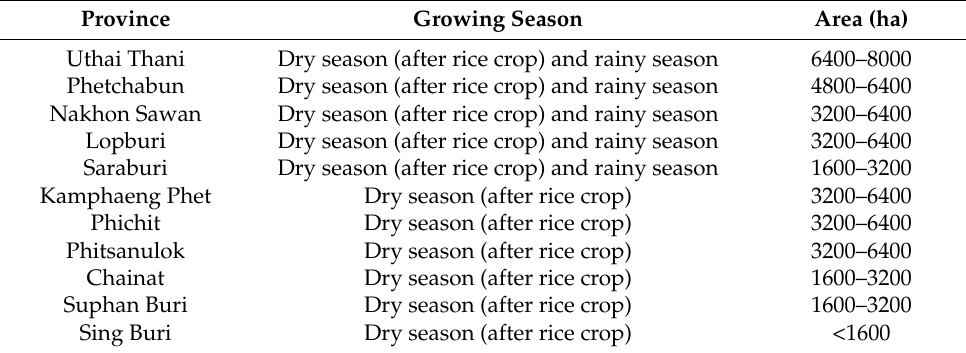
Table 2. Mung bean planting area in 11 provinces in central